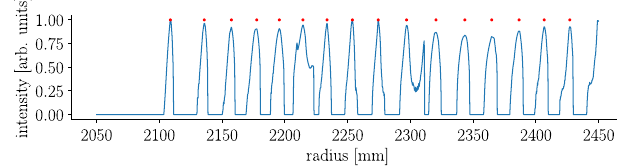
FIG. 3. Histogram of the probe RRI2 measurement. The intensity is normalized. The red dots mark detected peaks.